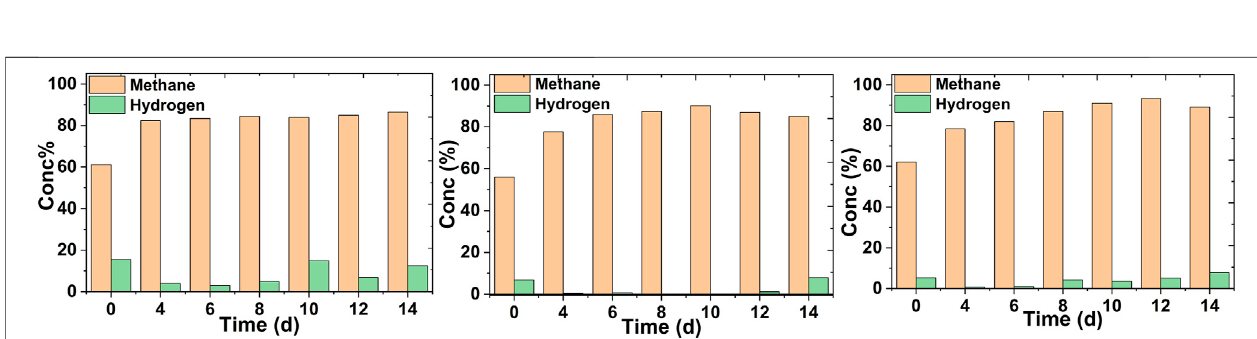
FIGURE 3 | Methane concentration pro fi les in the off-gas of the MES reactors fed with biogas continuously at different feed rates of 0.5 ml/min (A) , 0.3 ml/min (B) and 0.2 ml/min (C) .